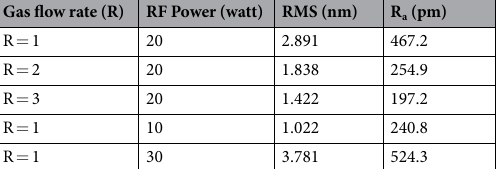
Table 4. The average roughness of L-PPA:N surfaces in functions of R at constant 20 W power and RF power at constant R =